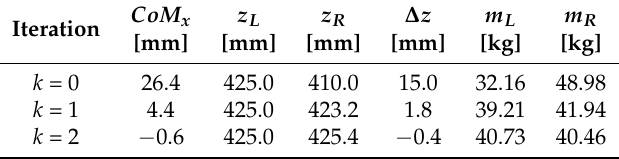
Table 5. Experiment 3: Figure 21 response values from for each iteration of the